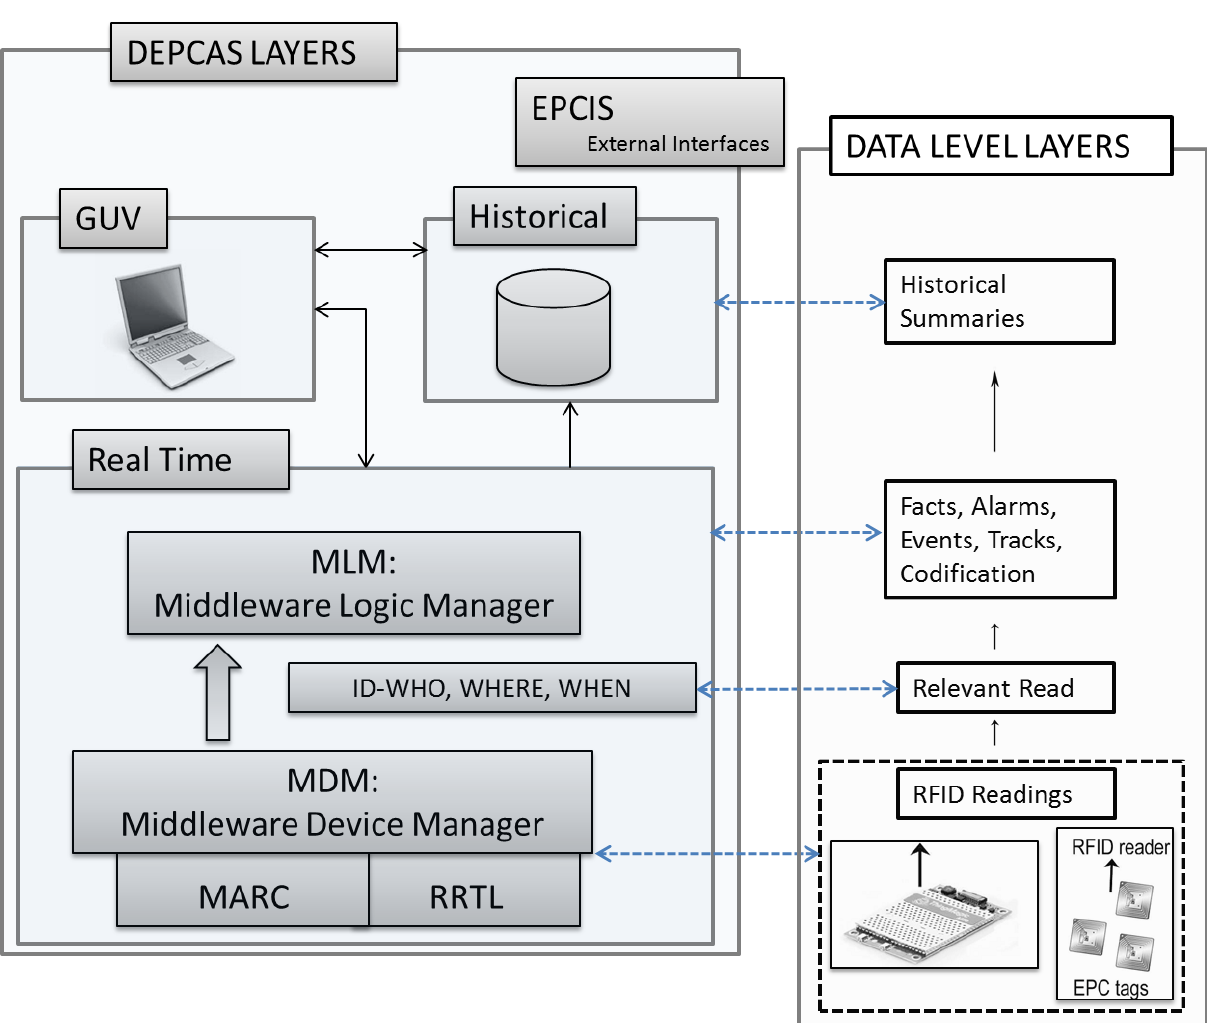
Figure 1. DEPCAS